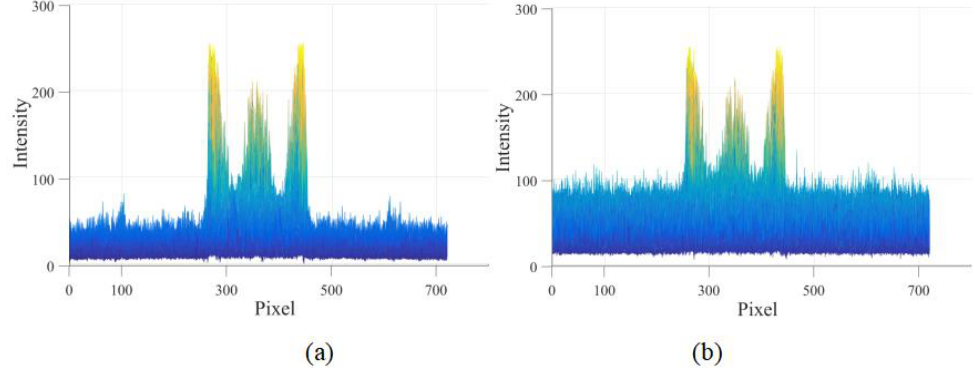
Figure 6. Side view of the intensities for the entire contents of Figure 5. ( a ) Intensity of Figure 5a; ( b ) intensity of Figure 5b.